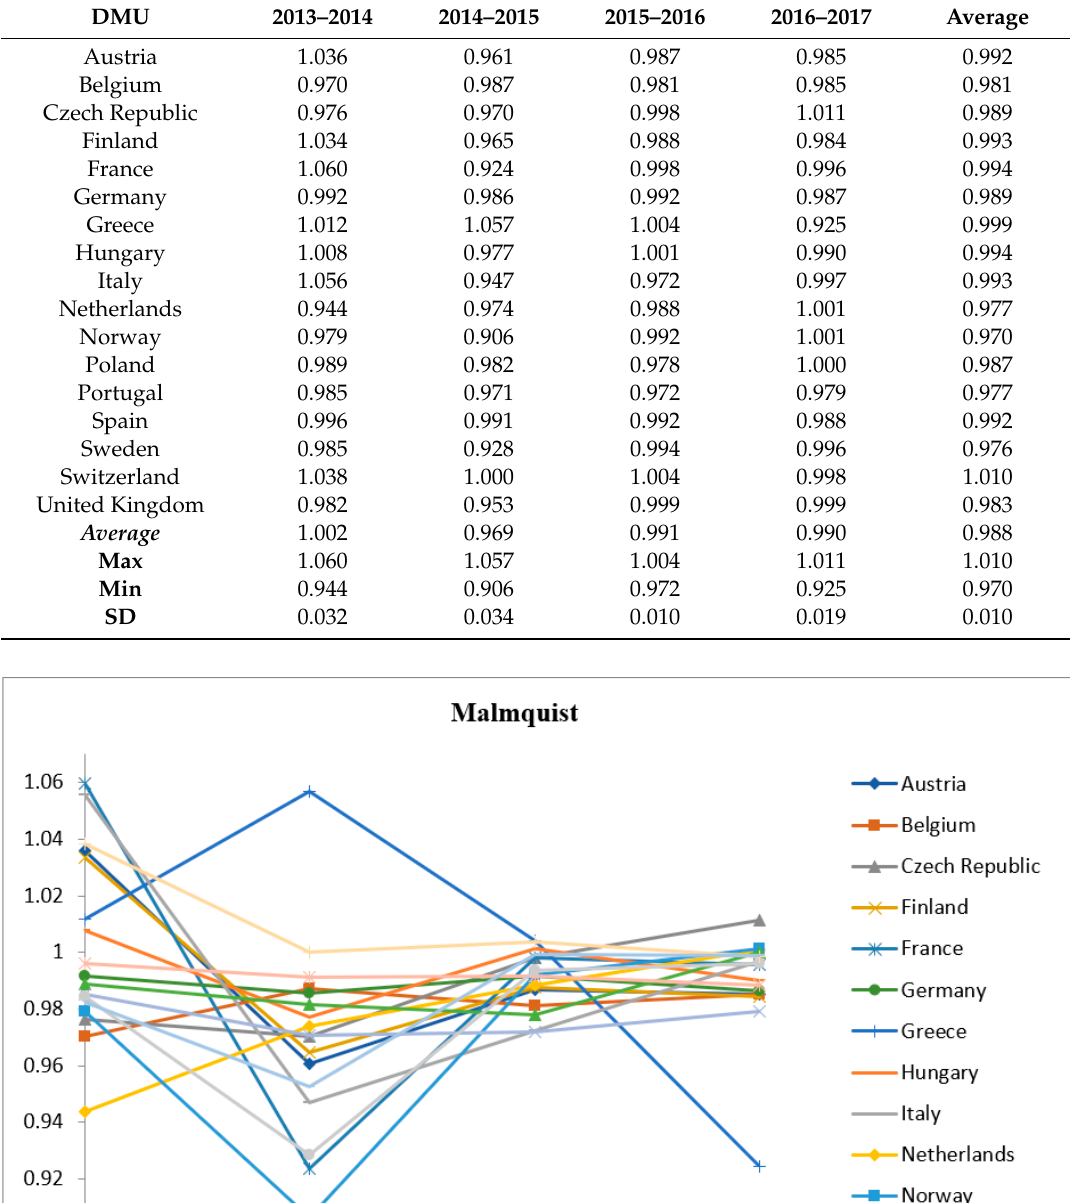
Table 9. Year-on-year MPI changes for the 17 DMUs from 2013 to 2017.